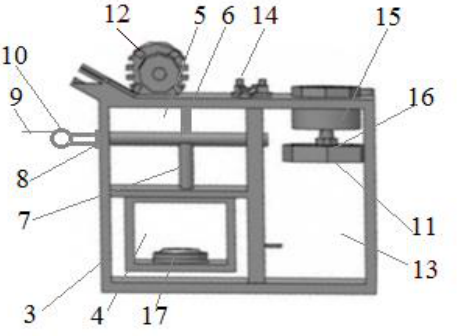
Fig. 4. Model of device for elimination of the crimping effect of the reusable